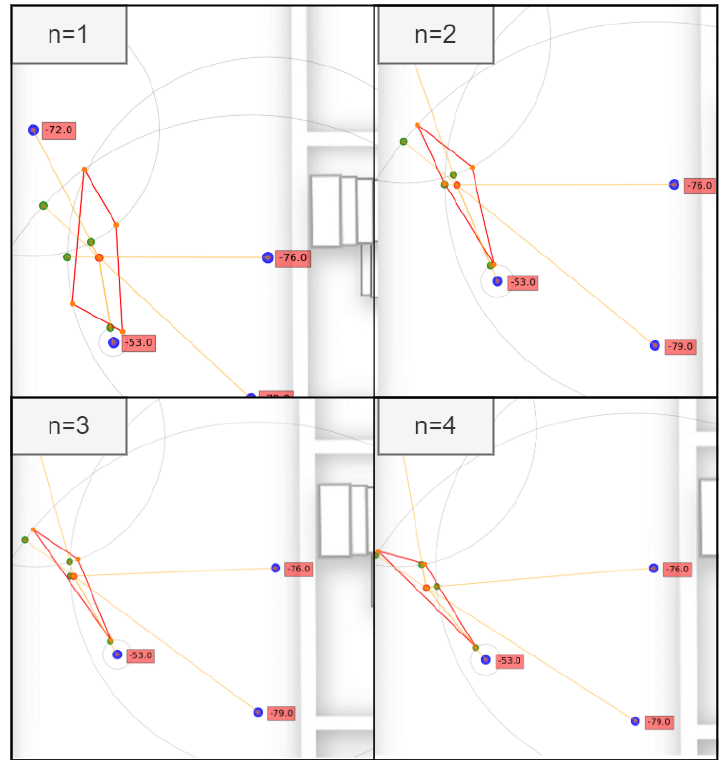
Figure 6. Evolution of the MZS each n